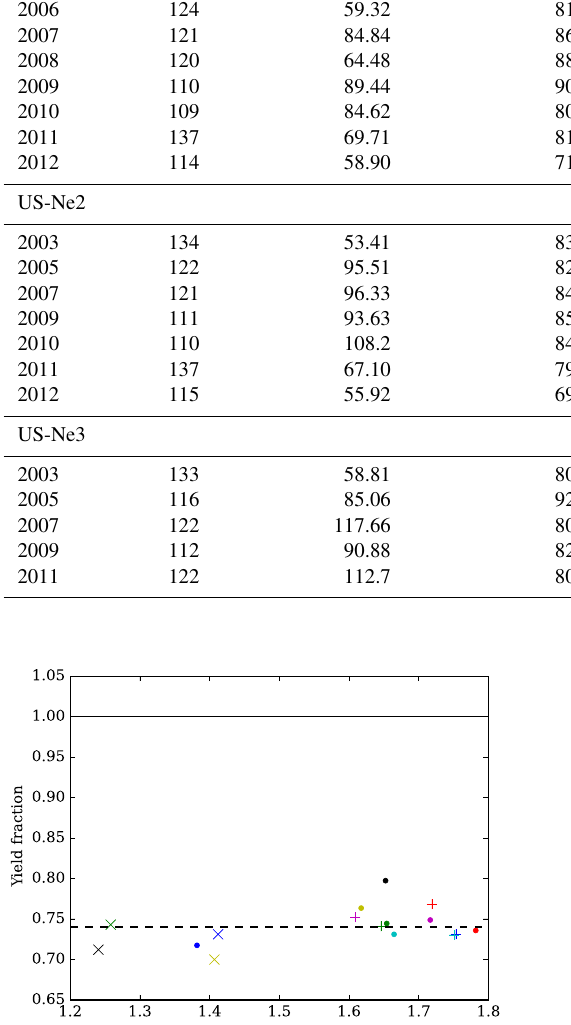
analysis scripts, without the need for extra JULES runs for each combination of parameters tested.